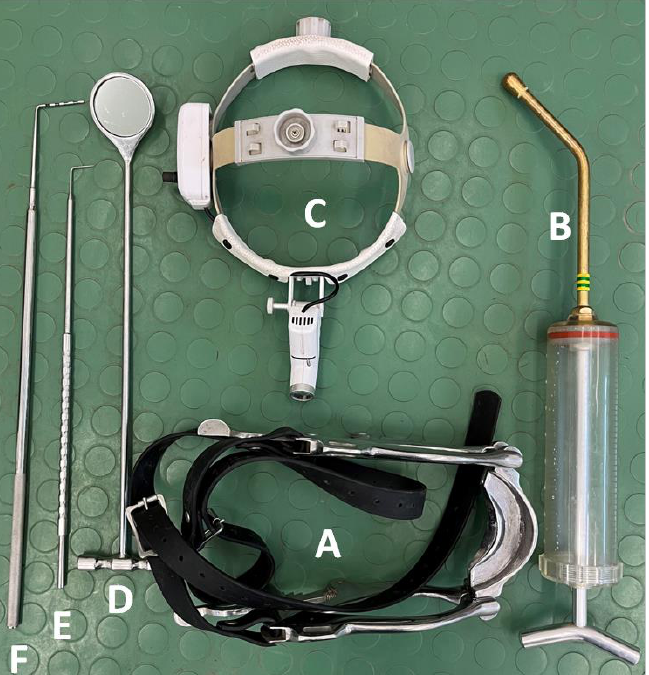
Figure 1. The equipment used in a detailed dental examination. Haussmann ’ s mouth speculum ( A ); 400 mL syringe ( B ); headlamp ( C ); dental mirror ( D ); dental hook ( E ); and periodontal probe ( F